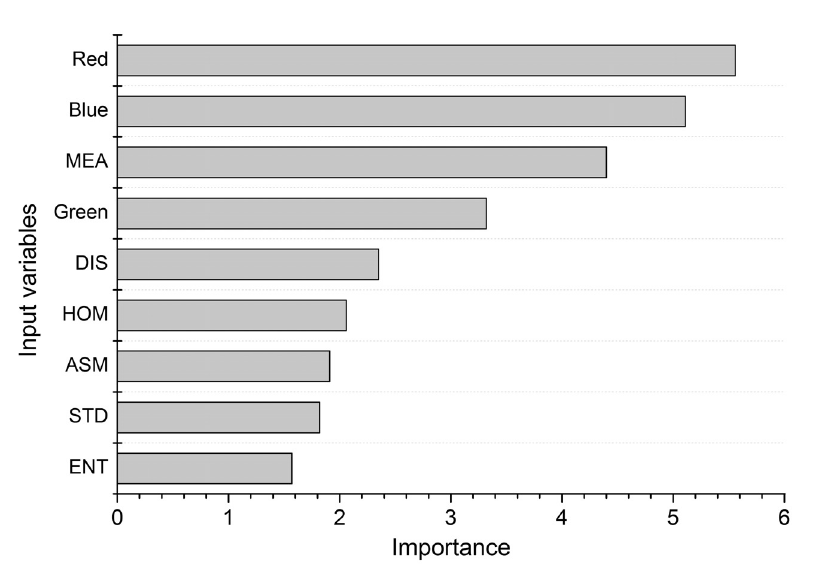
Figure 10. Importance of input variables.